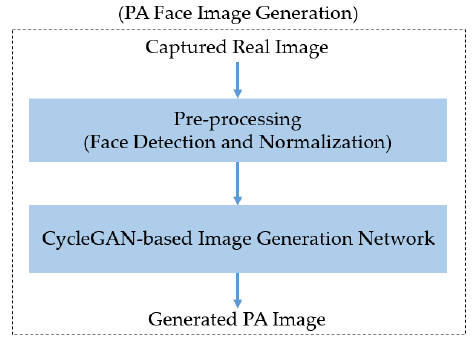
Figure 1. Overview of our proposed method for generating PA face images.